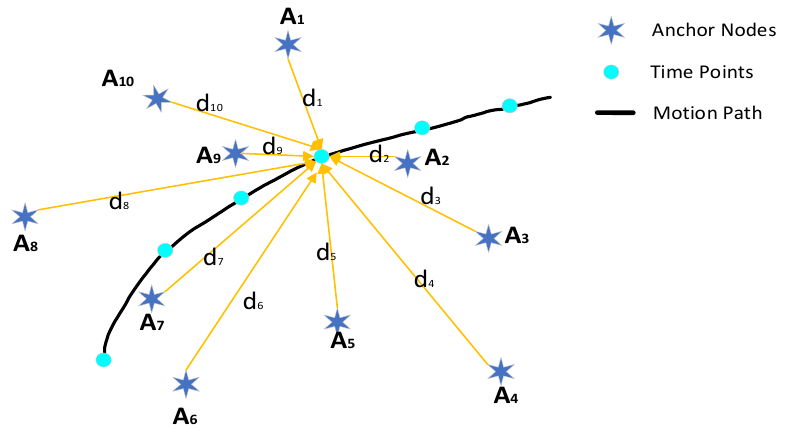
Figure 3. Anchor nodes and mobile nodes’ path.